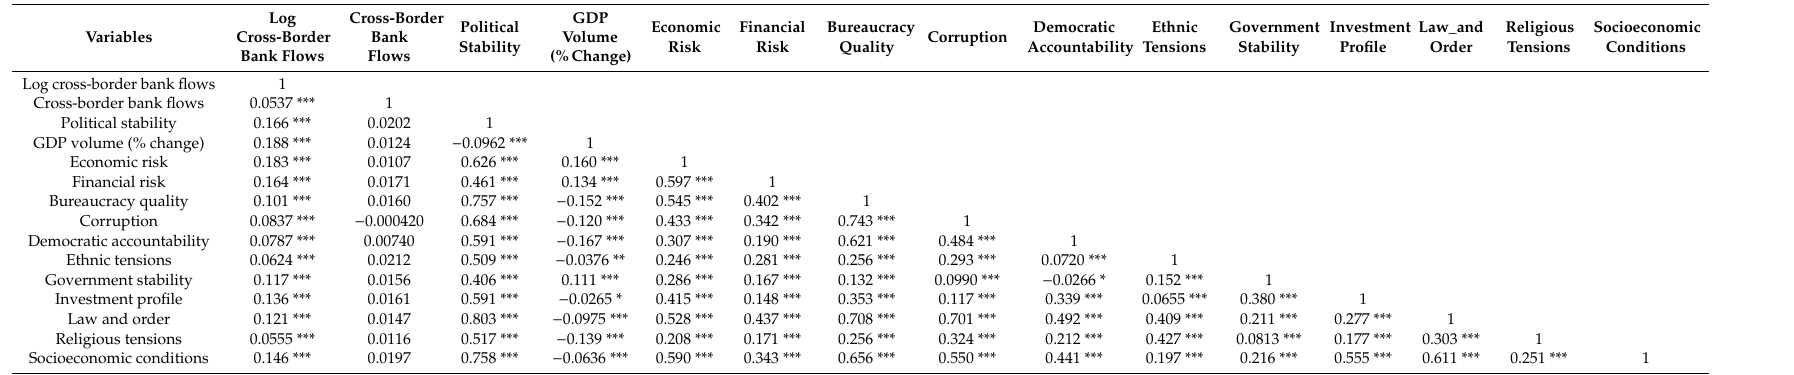
Table A4. Correlation